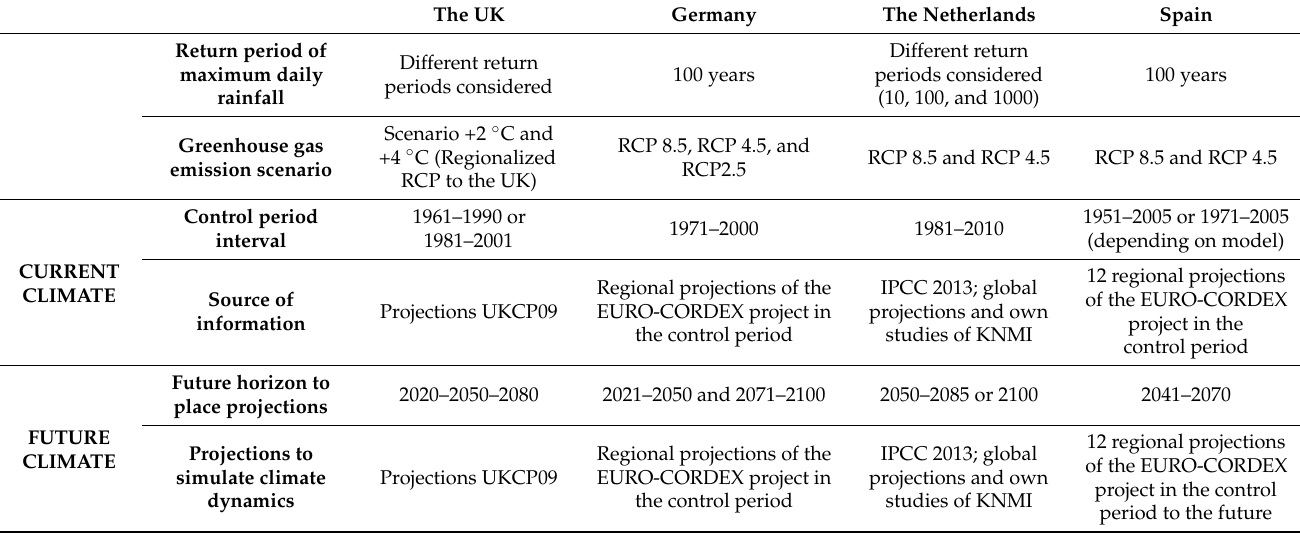
Table 5. Starting hypotheses for maximum rainfall and accumulated